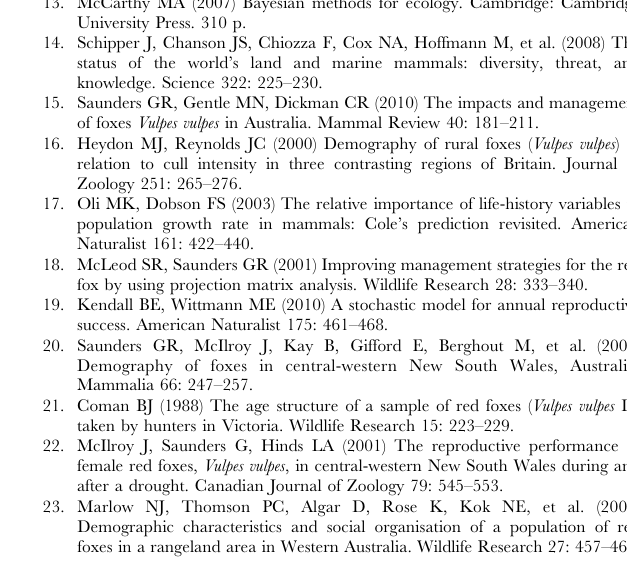
Figure S1 Likelihood distributions for vital rates simulated with varying sample sizes. Average survival rates of 0.1, 0.5, and 1.0 are simulated with varying age class sample sizes: (a–c) N= 10, (d–f) N= 100. All likelihoods were rescaled to peak at 1.0.